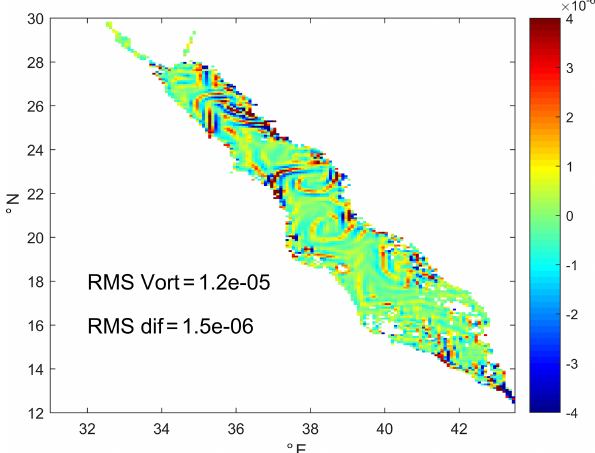
Figure 11. Snapshot of a difference in the surface current vortic- ity (s − 1 ) calculated from SMORS and PHY_001_024 models for 1 April